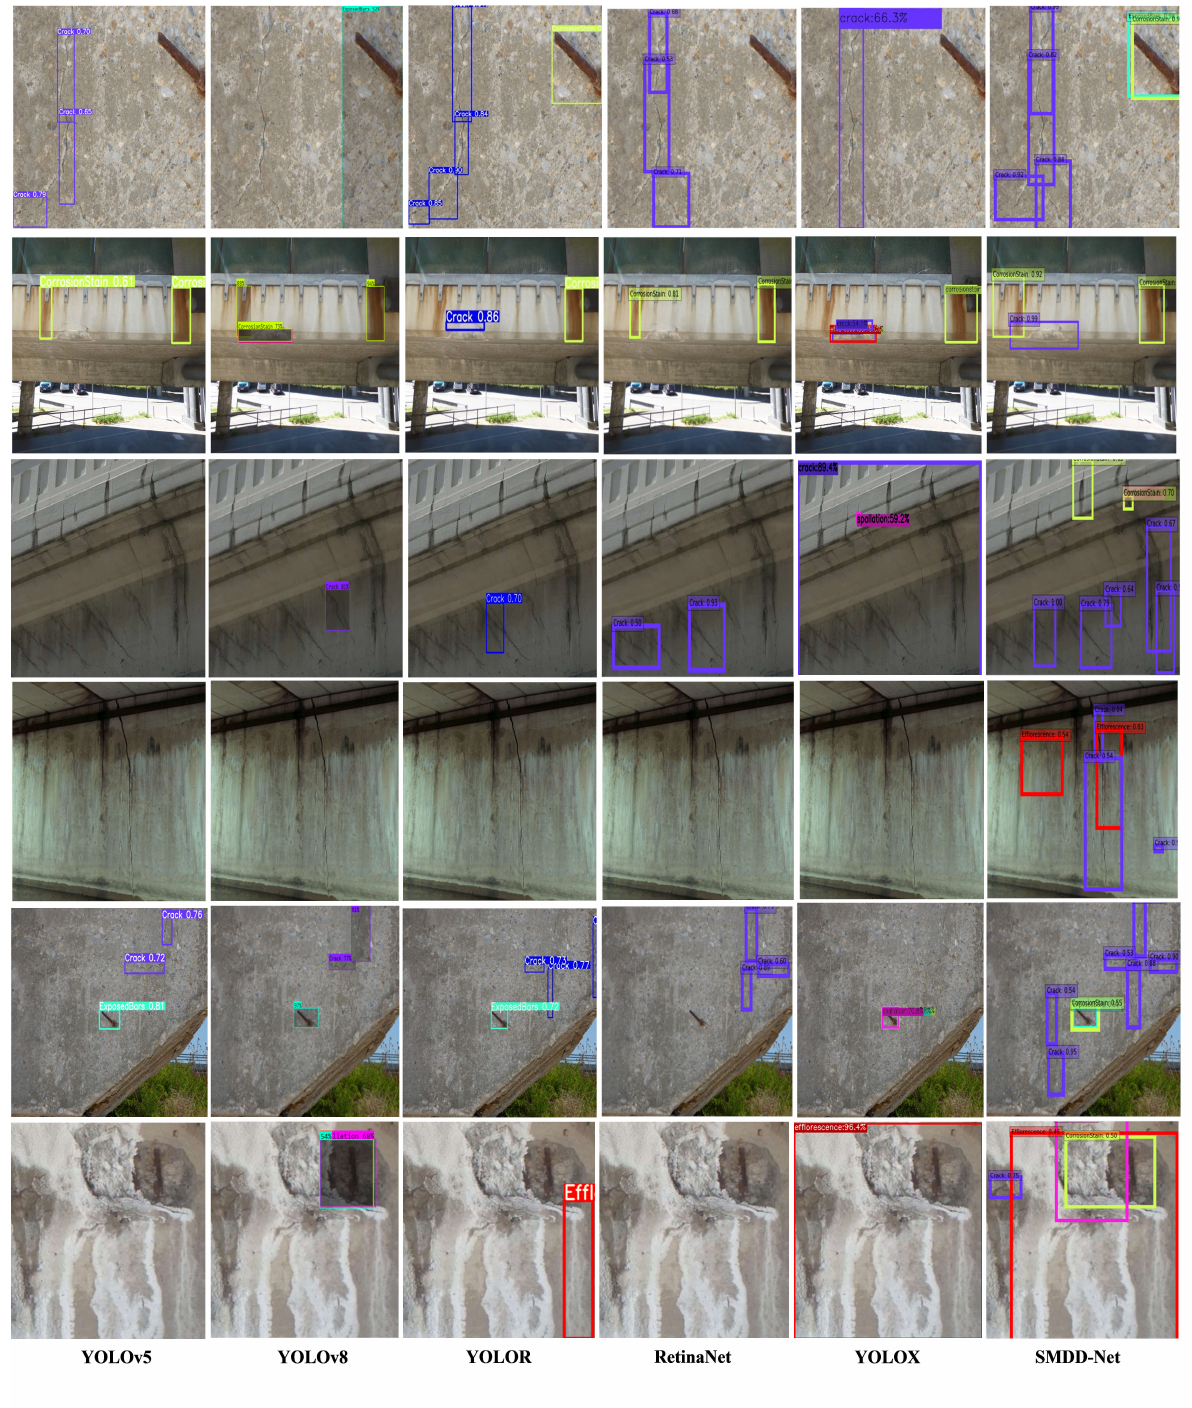
Figure 6. Visualisation of the compared results from concrete surface